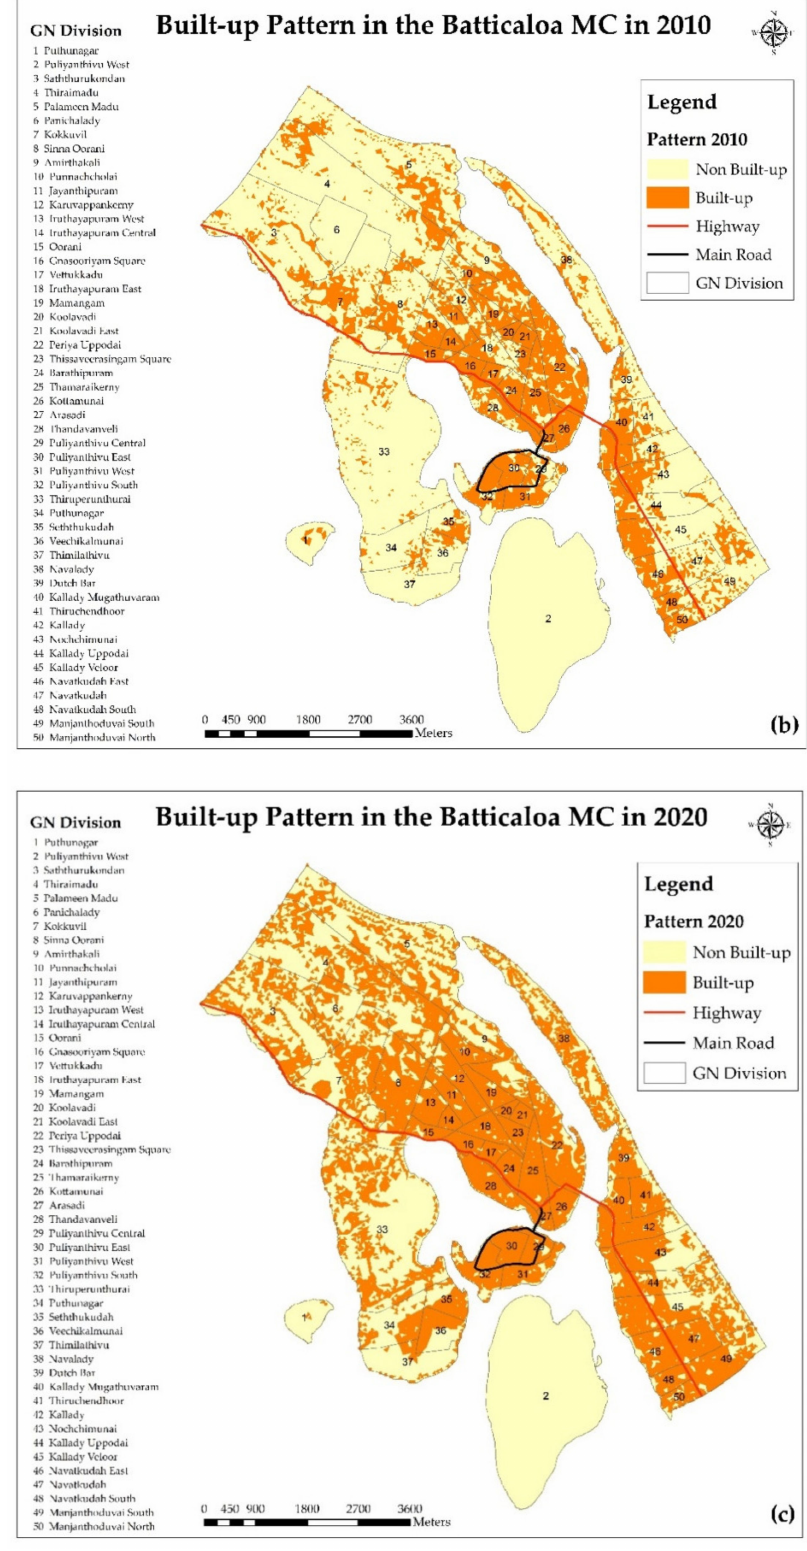
Figure 4. Built-up patterns in the Batticaloa Municipal Council in ( a ) 2000, ( b ) 2010, and ( c ) 2020. Note: The Grama Niladhari Division (GN) is a subdivision of the Divisional Secretariat in Sri Lanka. A total of 14,022 Grama Niladhari divisions are in charge of 331 Divisional Secretariat divisions in Sri Lanka; of these, 48 of Grama Niladhari divisions are in the Batticaloa